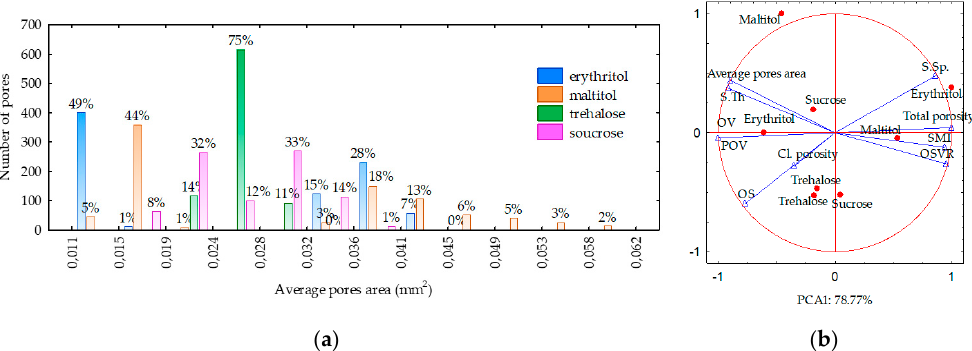
Figure 3. Structure of sponge cakes with sweetener: ( a ) distribution of pore size; and ( b ) PCA diagram of the 2D and 3D structural parameters. POV, percent object volume; OSVR, object surface/volume ratio; OV, object volume; OS, object surface; SMI, structure model index; S.Th, structural thickness; S.Sp, structure